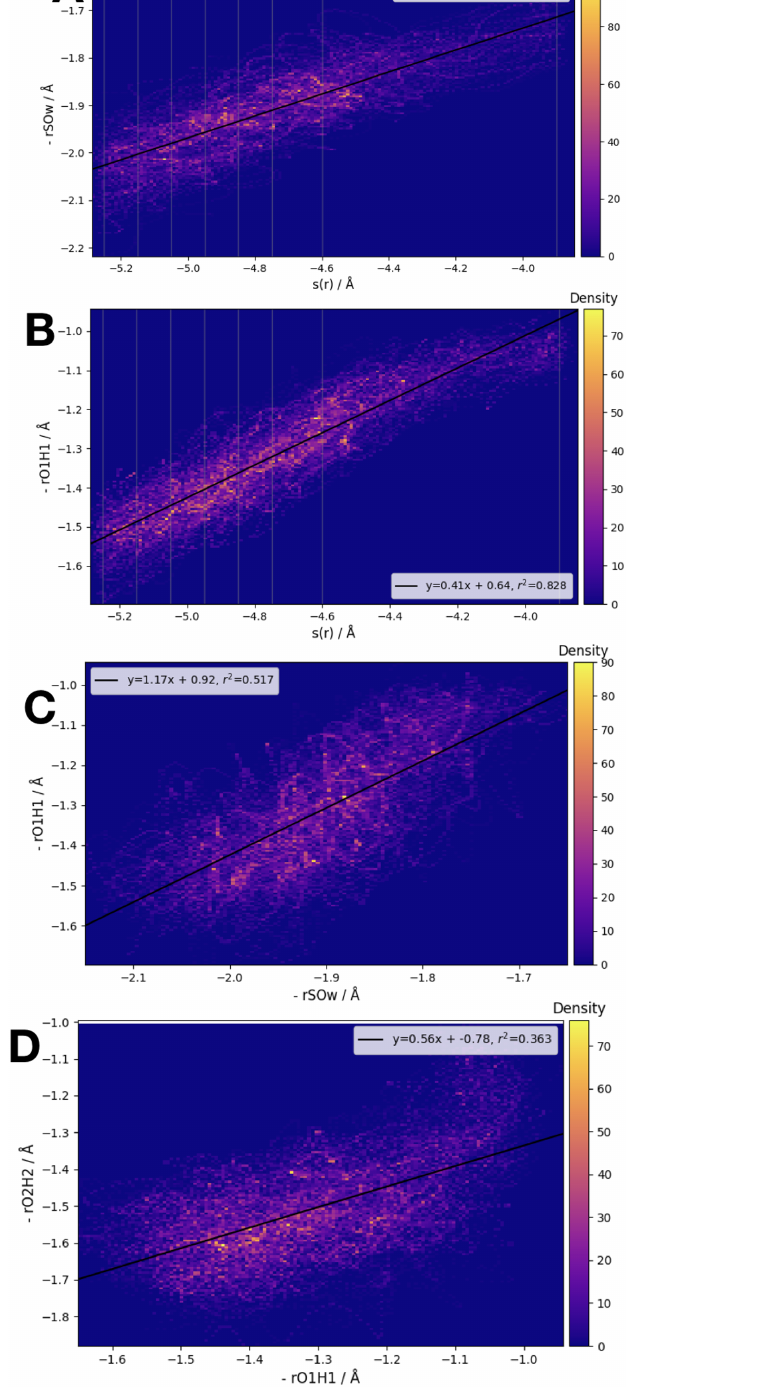
Figure 5 Frame densities for trajectories beginning in the fi nal RETIS ensemble ( − 3.9 Å > s ( r ) > − 4.6 Å). Interface locations λ i are indicated by the vertical lines when s ( r ) is plotted on the horizontal axis. (A) (cid:3) r SO vs. s ( r ), (B) (cid:3) r O vs. s ( r ), (C) (cid:3) r O vs. (cid:3) r SO and (D) (cid:3) r O vs. (cid:3) r O . W 1 H 1 1 H 1 W 2 H 2 1 H 1 Full-size  DOI: 10.7717/peerj-pchem.7/ fi